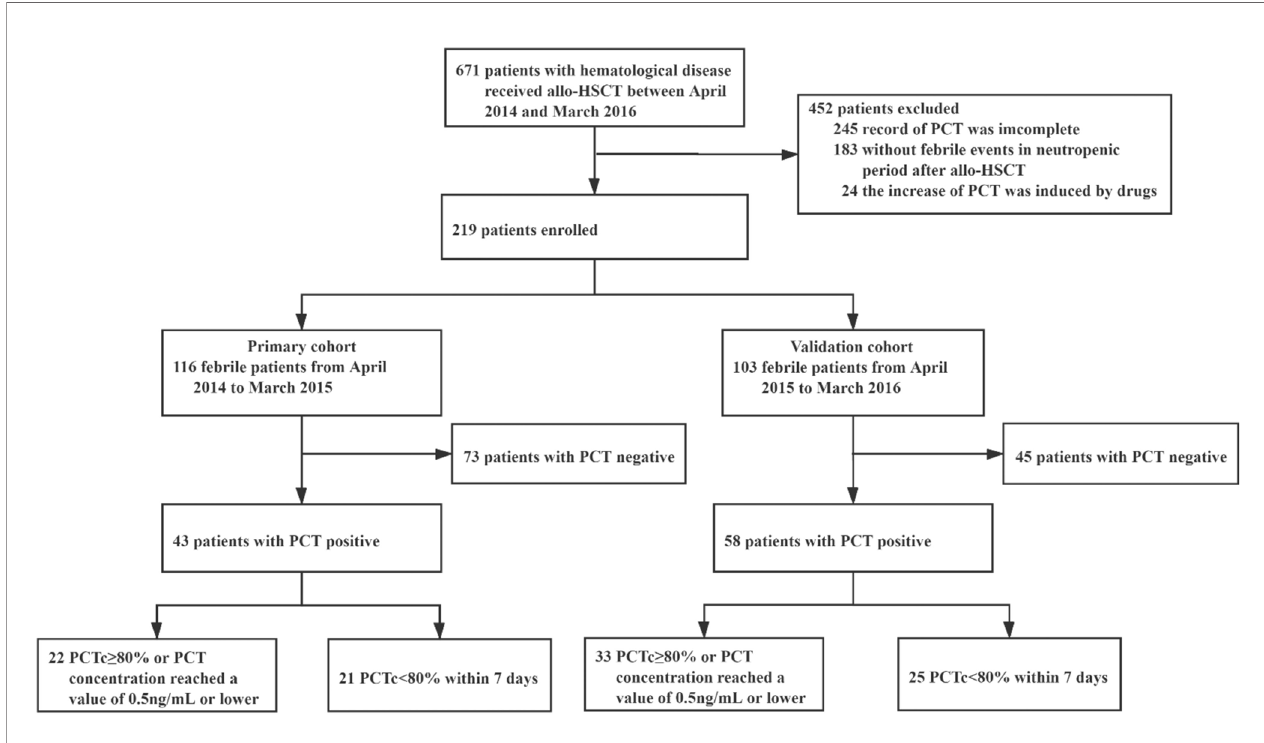
FIGURE 1 | The study pro fi